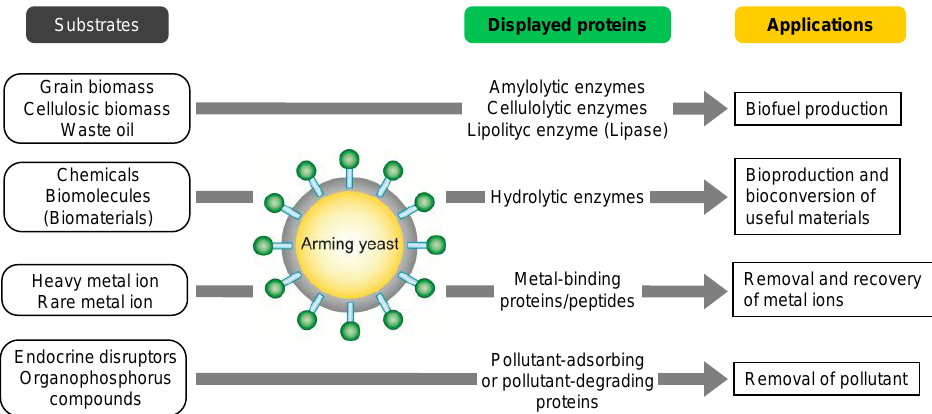
Figure 2. Whole-cell biocatalyst constructed by arming technology and their